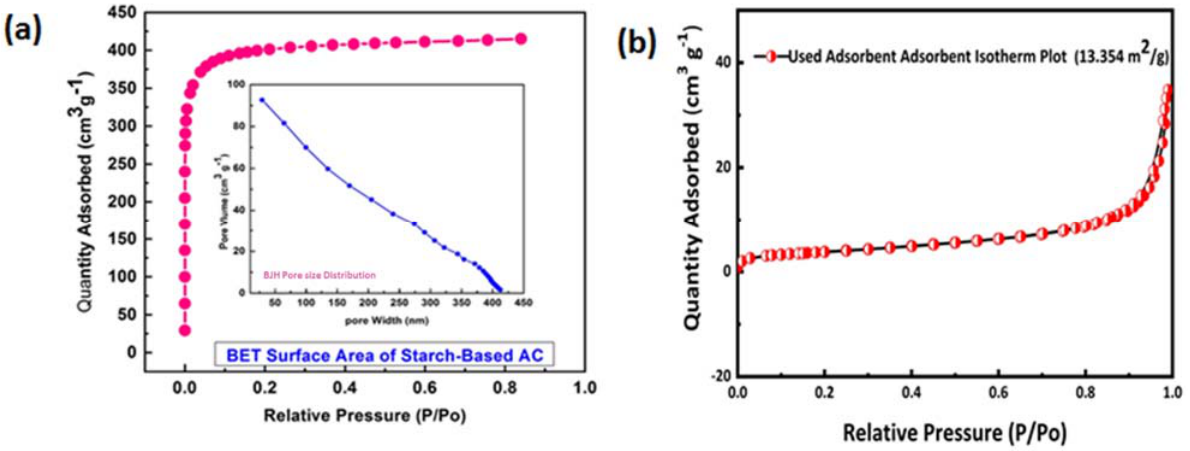
Figure 7. ( a ) Nitrogen sorption isotherm of starch-based AC at 77.5 K with inset of BJH pore size distribution and ( b ) BET isotherm of the Cd (II)-ion-loaded AC.